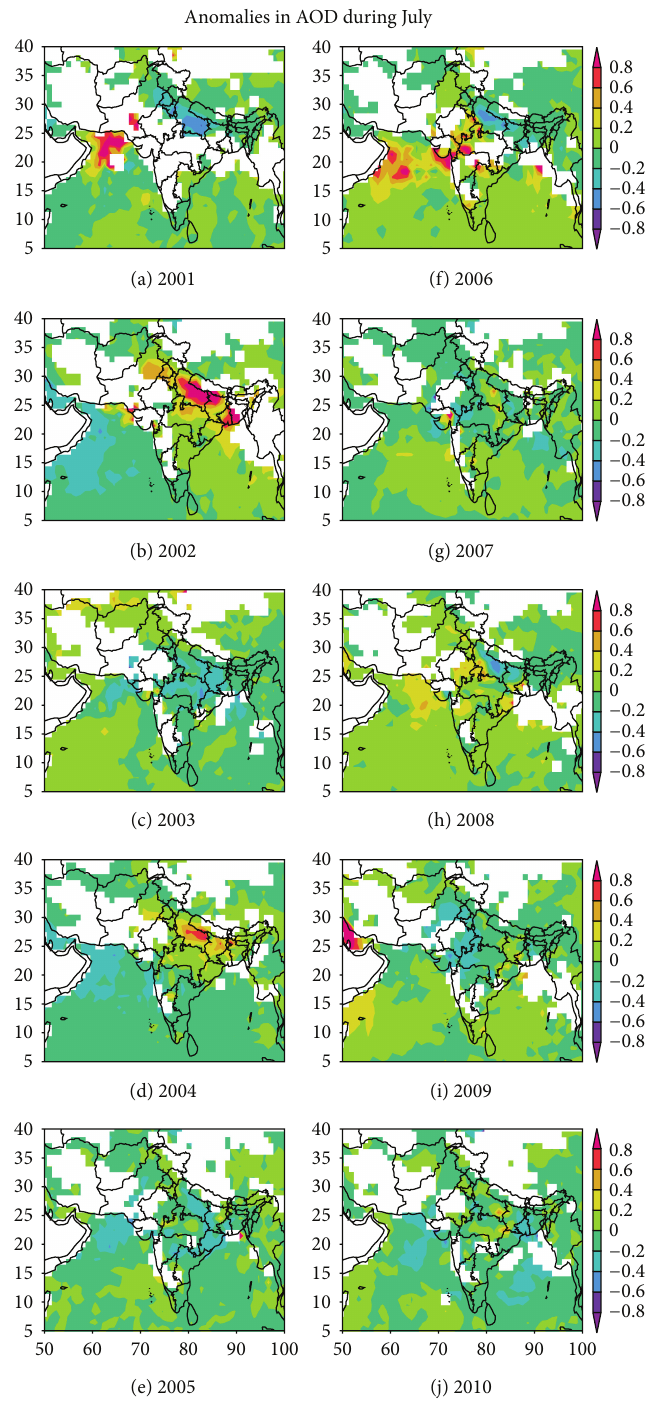
Figure 5: Anomalies in aerosol optical depth (AOD) during July from 2001 to 2010 ((a)–(j)) over the study regions.